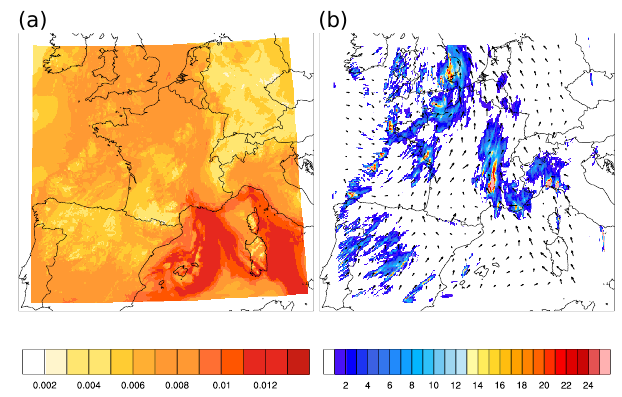
Figure 2. (a) Specific humidity ( q , kgkg − 1 ) and (b) surface cu- mulative precipitation (mmh − 1 ) overlaid with winds vector at model level 52 ( ≈ 920hPa). Maps are given for one member of the AROME-France 3h forecasts ensemble, valid at 03:00UTC on 4 November